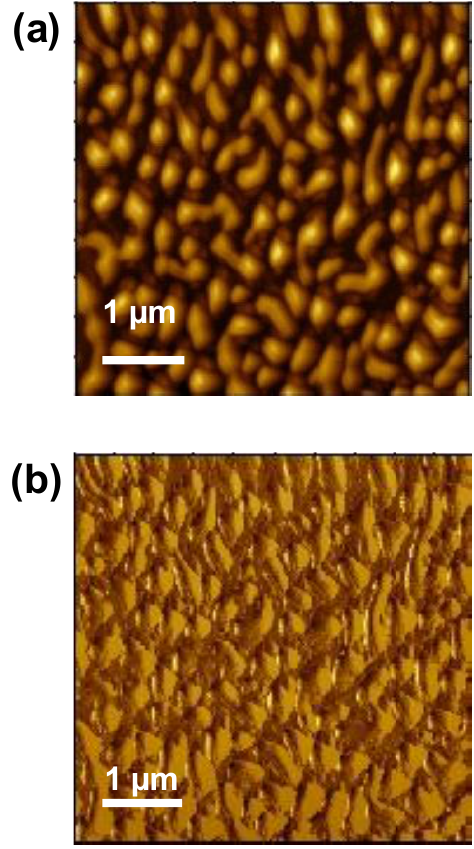
Figure 3. SFM ( a ) height (z-range = 40 nm) and ( b ) phase (z-range = 60°) images of poly(NVI-NTf 2 ) 48 - b -poly(NIPAM) 52 . The sample was prepared by drop-casting of the acetone solution of the amphiphilic block copolymer onto mica substrates.